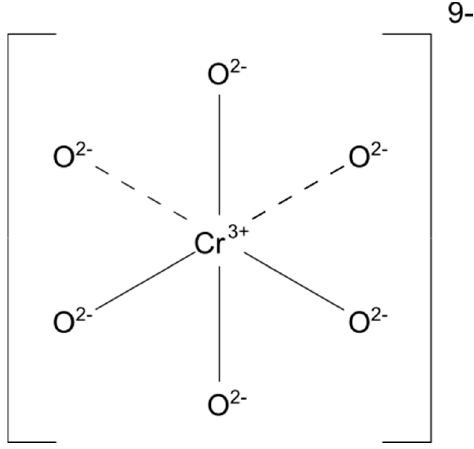
Figure 19. Diagram of octahedral site of the Cr 3+ cation and six O 2 − nearest neighbor ligating anions in ruby.